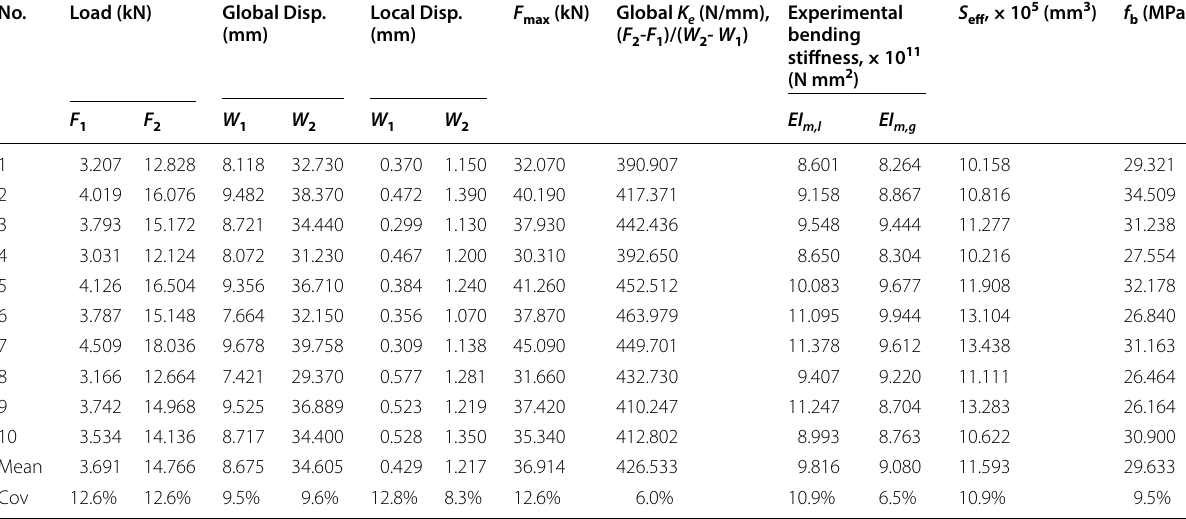
Table 7 Experimental results for 5-layer CLT bending panels (CL5/155/4800) No. Load